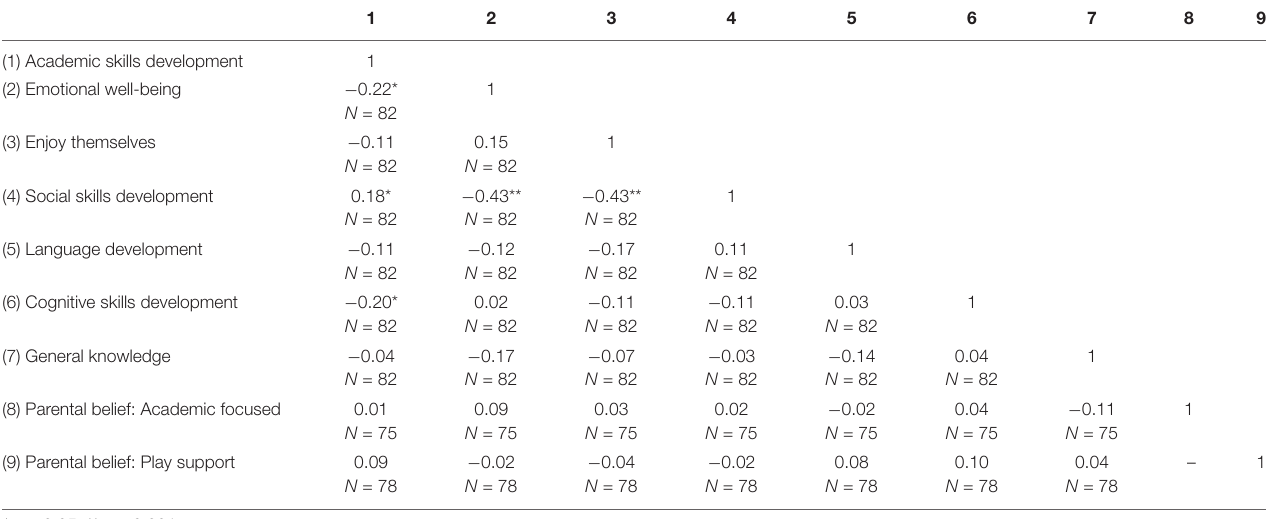
TABLE 5 | Kendall’s tau-b correlations among parental play beliefs and views about the purpose of preschool education variables. 1 2